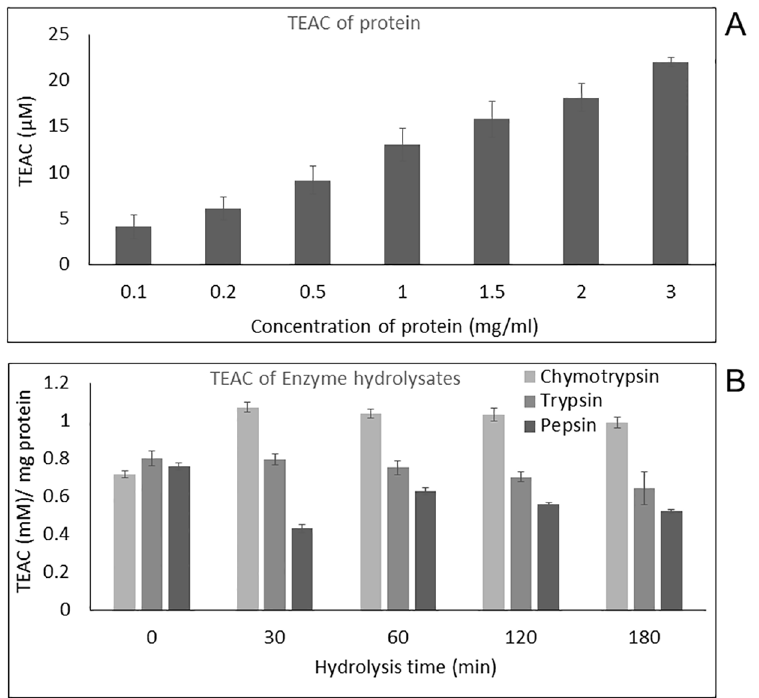
Fig 5. Trolox equivalent antioxidant capacity. (A) TEAC of T . cordifolia stem proteins using ABTS as oxidant; (B) TEAC of different enzyme hydrolysates (trypsin, chymotrypsin, and pepsin) of T . cordifolia stem proteins using ABTS as the